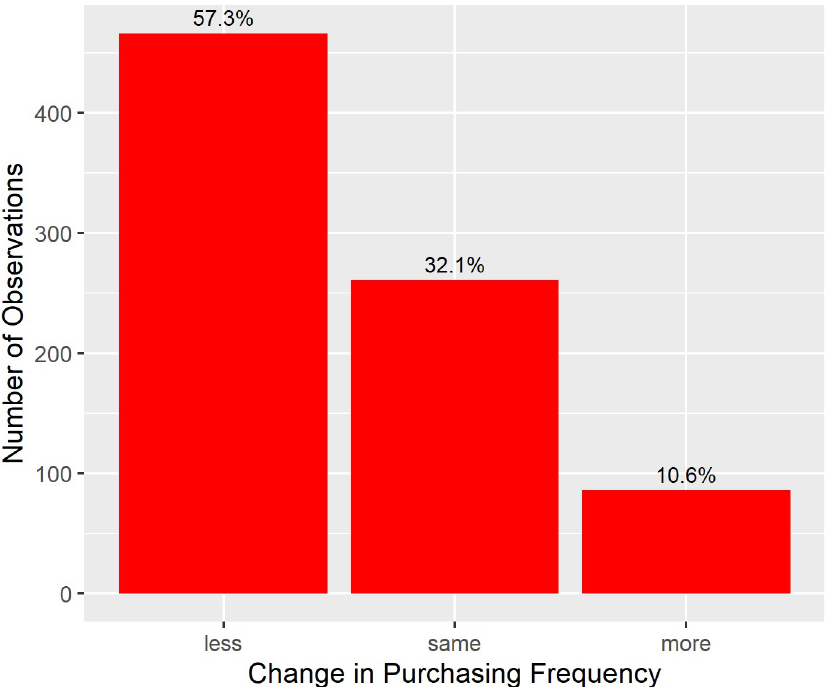
Fig 1. Distribution of subjective change in purchasing frequency in March compared to January 2020. N = 813. Note that categories “less” and “more” each comprise three gradations of the original scale (see section Outcome Measures